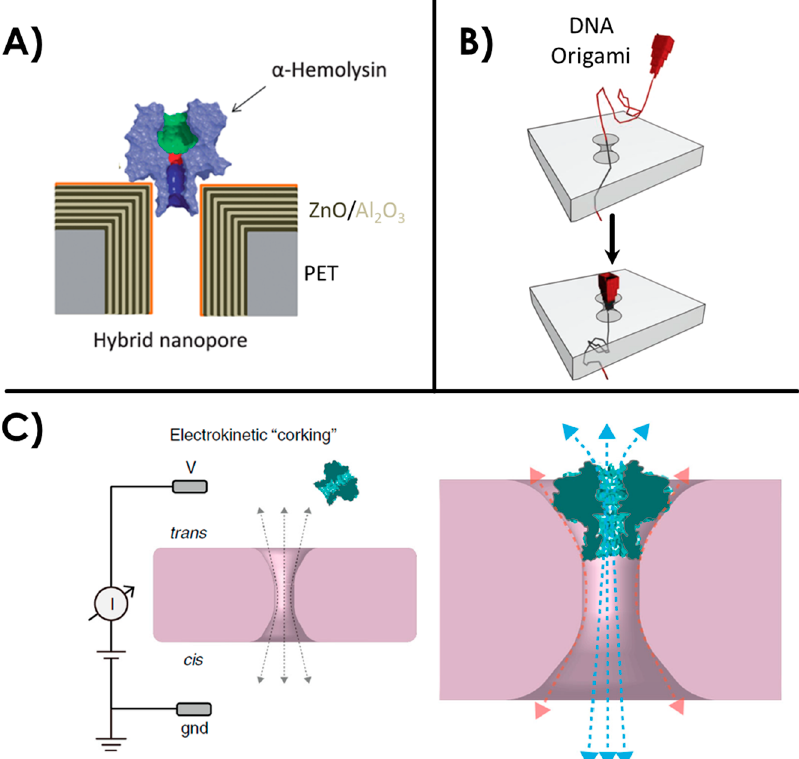
Figure 3. Examples of hybrid nanopores. ( A ) A hybrid nanopore consisting in a α -hemolysin biological pore inserted in a solid-state nanopore, adapted from [58]. ( B ) A DNA origami nanopore. Reprinted adapted with permission from [65]. Copyright 2012 American Chemical Society. ( C ) Virus portal protein inserted in a solid-state nanopore from reference [62].